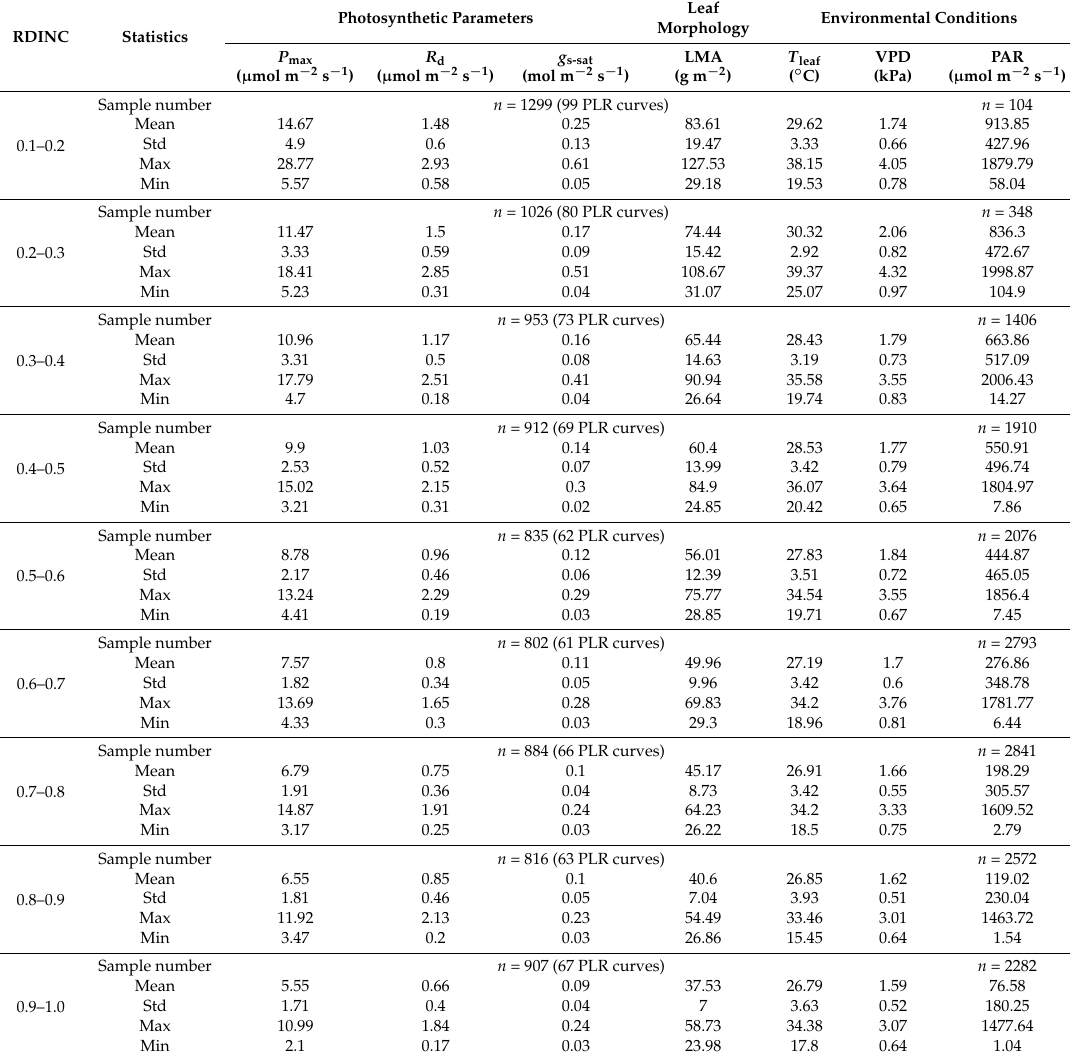
Table 2. Descriptive statistics of the photosynthetic parameters, leaf morphology and corresponding environmental